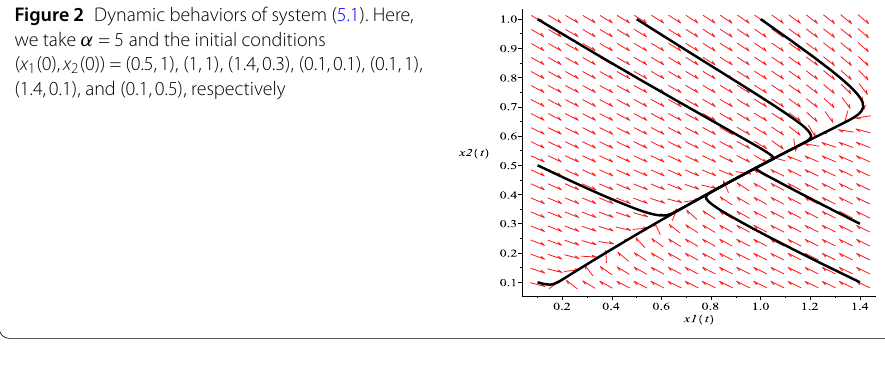
Figure 3 Numeric simulations of the first component x 1 ( t ) of system (5.4), with m = 0.1,0.3,0.5, where black curve is the solution of m = 0.1, blue curve is the solution of m = 0.3, and red curve is the solution of m = 0.5, and ( x 1 (0), x 2 (0)) =